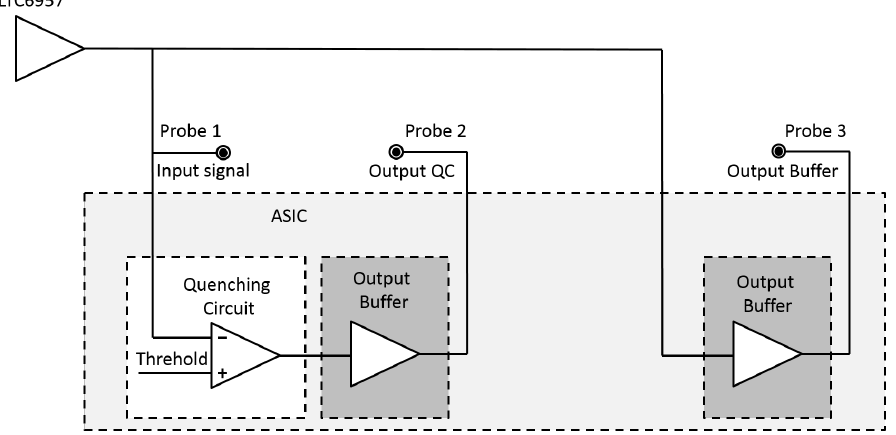
Figure 6. Simplified integrated electronics diagram of the timing setup for the quenching